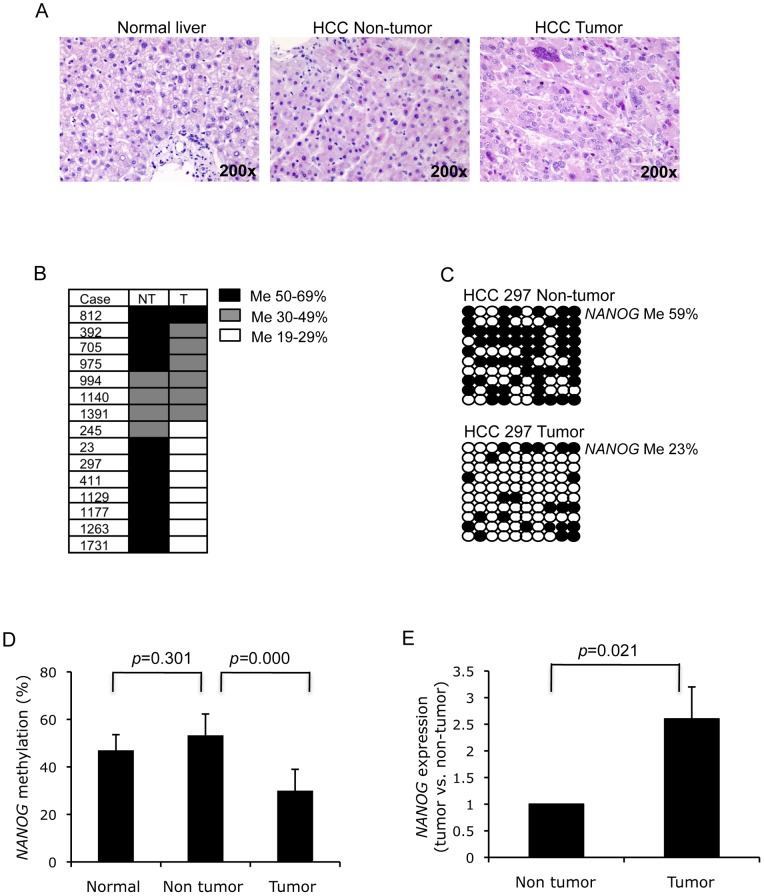
Deregulation of NANOG in HCC primary tumor tissue.(A) H&E staining of human normal liver (left), and HCC non-tumor (middle) and tumor tissue (right). (B) Methylation status of the NANOG promoter (−1449 to −952) in fifteen paired HCC non-tumor and tumor tissues. DNA methylation frequency was classified into 50–69% (black), 30–49% (grey), and 19–29% (white) in HCC tumor and adjacent non-tumor tissues. (C) NANOG promoter methylation pattern is represented with HCC case-297 tumor and adjacent non-tumor tissue. (D) Statistical comparison of NANOG promoter methylation in normal liver (n = 3), HCC adjacent non-tumor (n = 15) and tumor (n = 15) tissues; data are the mean ± SD. (E) Statistical comparison of NANOG gene expression in paired HCC non-tumor and tumor tissue (n = 15). Each tumor tissue was normalized with its corresponding non-tumor tissue.